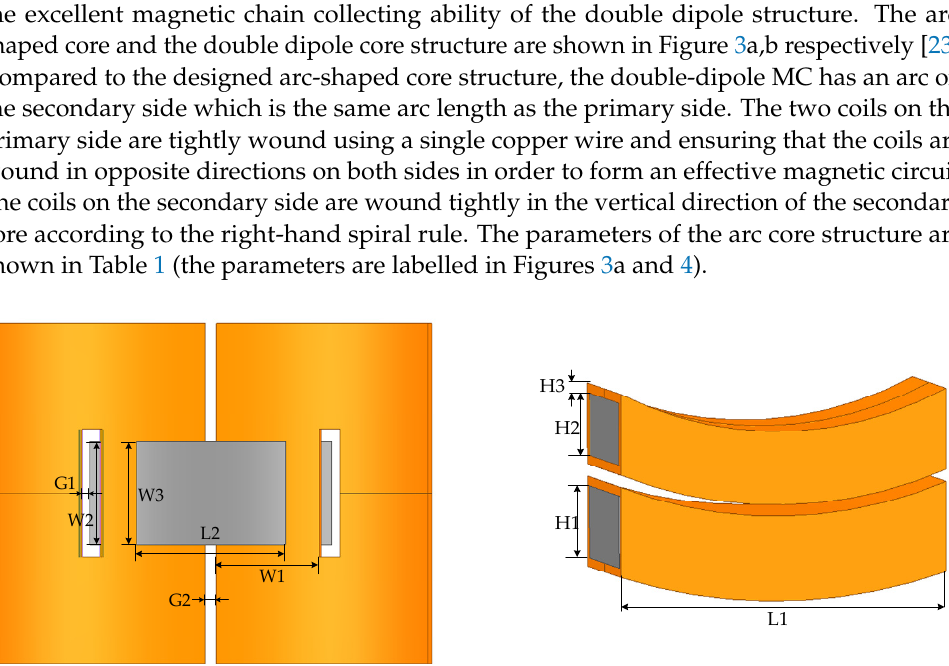
Figure 4. Schematic diagram of misalignment. Table 1. Parameters of the MC. Symbol